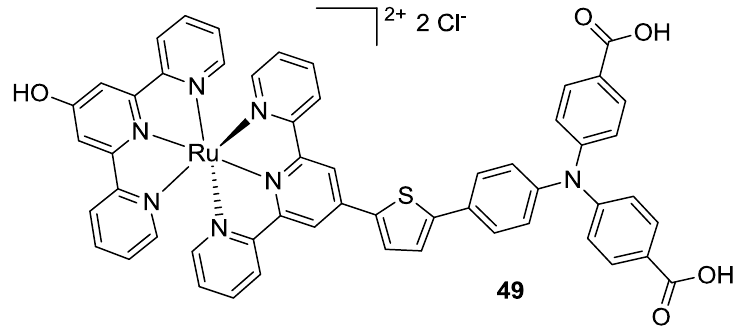
Figure 40. “K1” structure proposed by Wood et al. [164].